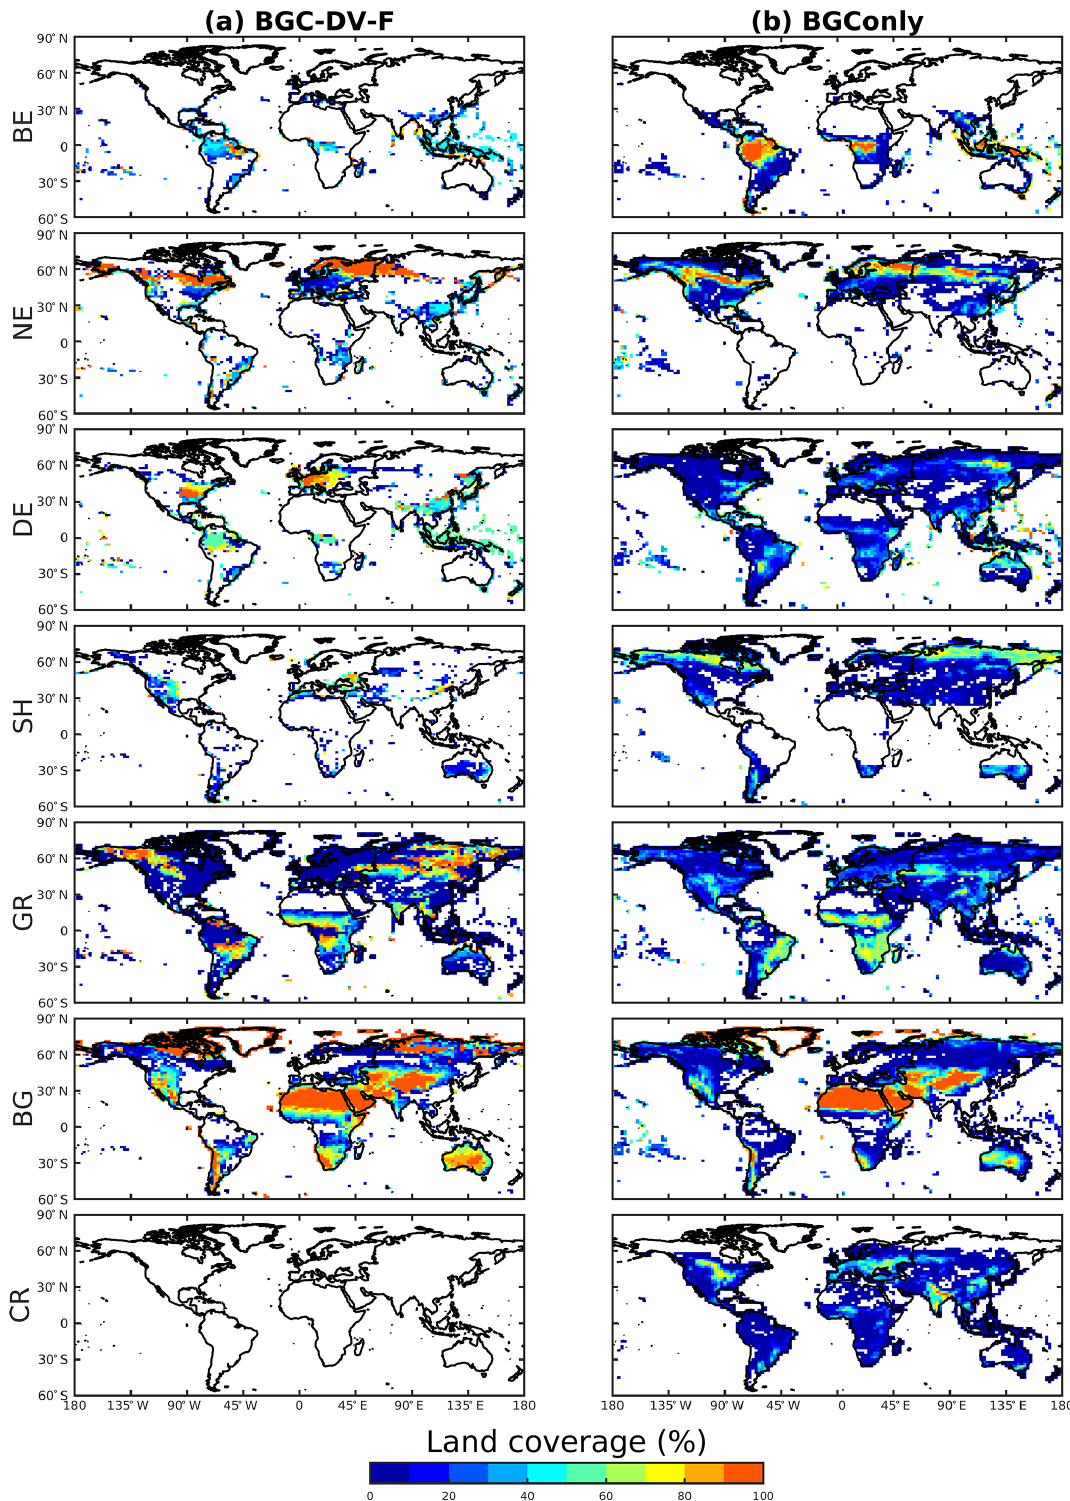
Figure 3. Percentages of land cover type (broadleaf evergreen (BE)), needleleaf evergreen (NE), deciduous (DE), shrub (SH), grass (GR), bare ground (BG) and crop (CR)) in BGC-DV-F and BGConly (the same for both BGConly-F and